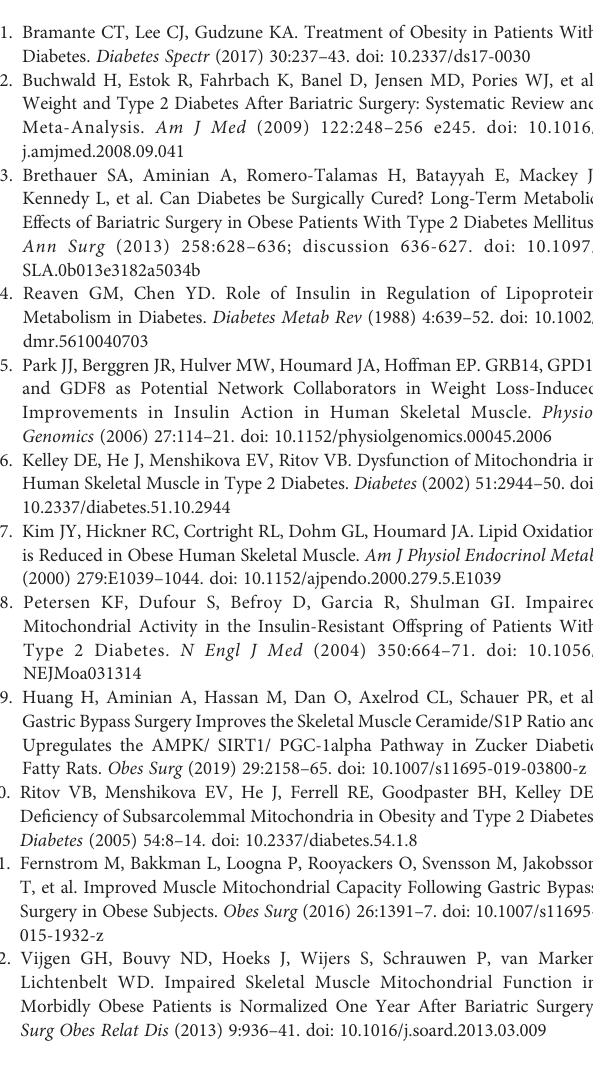
Supplementary Table 1 | Probes and statistics for the main effect of timepoint. Supplementary Table 2 | Probes and statistics for the main effect of group. Supplementary Table 3 | Probes and statistics for time x group interaction.